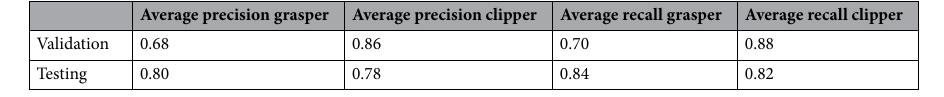
Table 3. Instrument detection evaluation